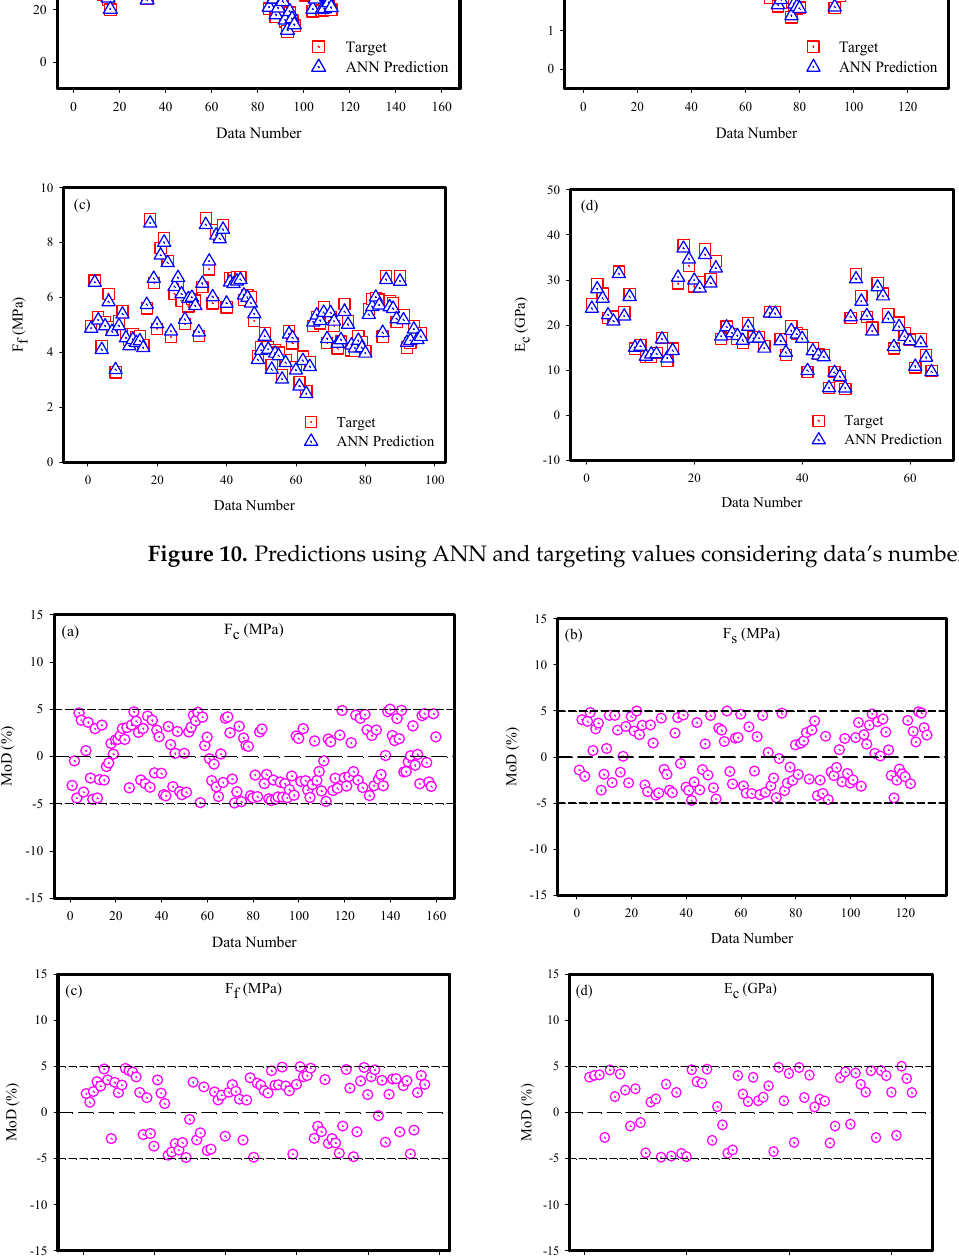
Figure 11. Values of MoD for each output considering data’s number. The targeted values of the Fc, Fs, Ff and Ec values differ from the ANN outputs in Figure 12, and a more thorough investigation of the ANN model’s predictive ability is planned. The graphs make it abundantly evident that the computed varaition values for every data points are small. The results of the MoD and difference values demonstrate that the constructed ANN model was developed to calculate Fc, Fs, Ff and Ec values with very low errors.